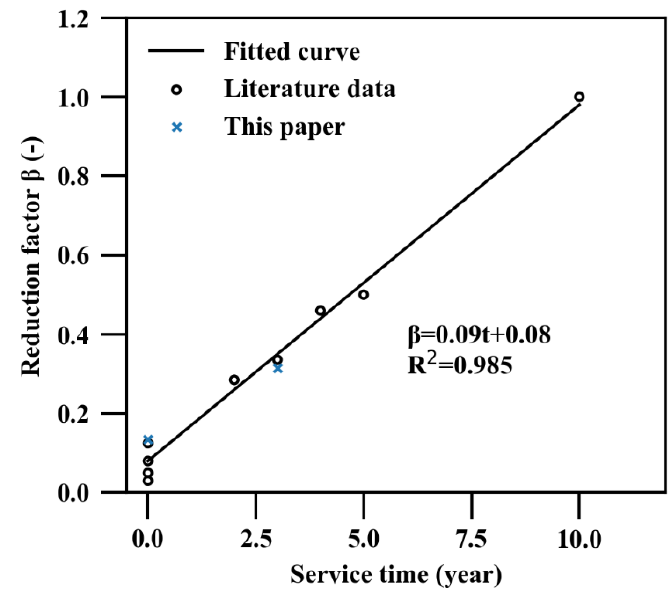
Figure 8. The relationship between the lining seepage reduction factor ( β ) and service time (t). Note: reduction factor ( β ) is the proportion of seepage rate of a canal with lining to that without lining. A bigger reduction factor ( β ) means more seepage rate from a lined canal.